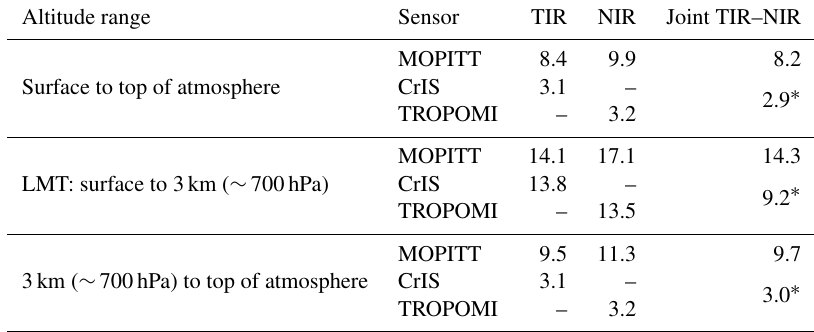
Table 5. Estimated percentage uncertainty for MOPITT, CrIS, and TROPOMI carbon monoxide